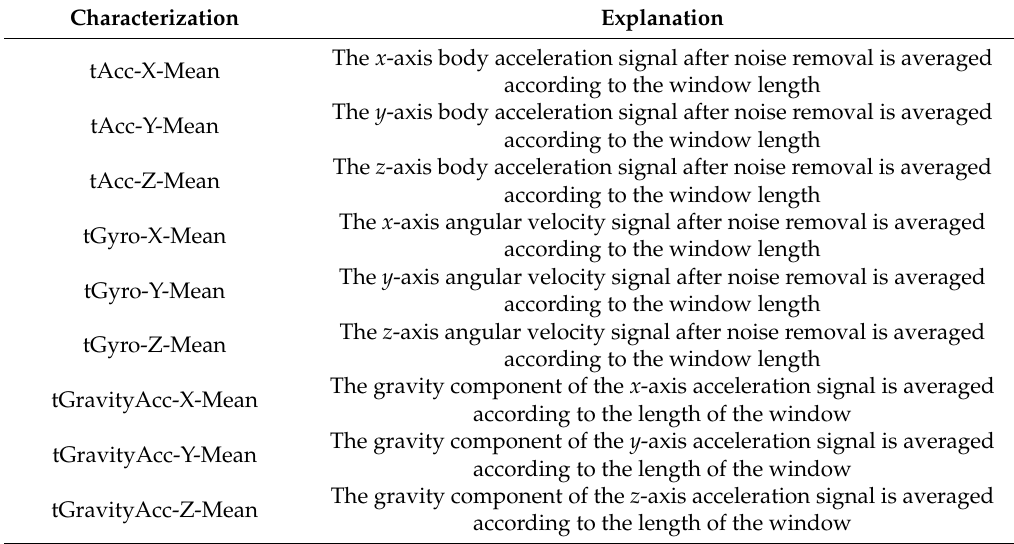
Table 4. Signal processing methods for feature